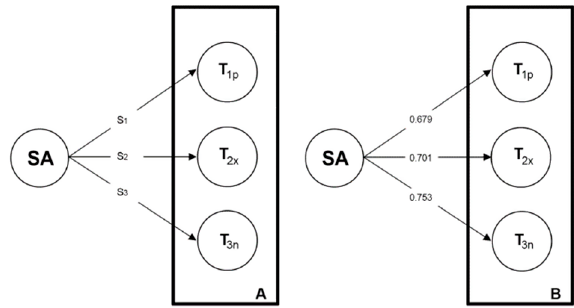
Figure 4. Sentiment analysis reliability results with Krippendorff’s alpha value. Source: Saura and Bennett [3].